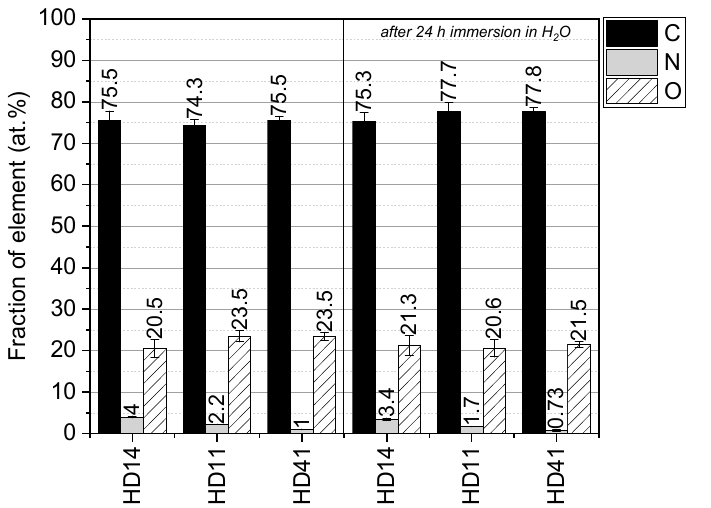
and the plasma-polymerized hydrogel coatings ( b ): HD14, ( c ): HD11, ( d ): HD41) deposited on gold, generated through the droplet method.